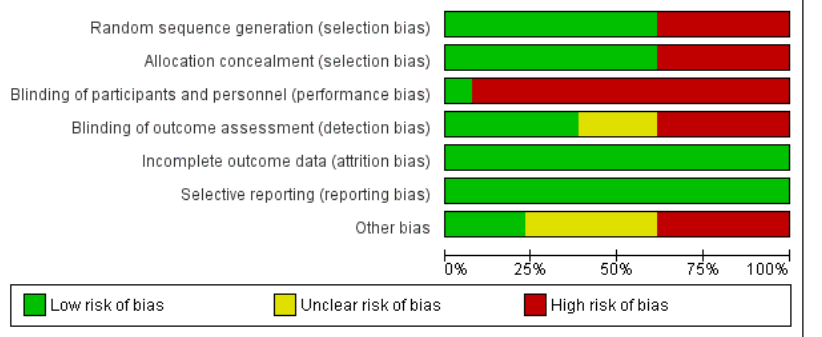
Figure 2. Risk of bias: reviewers ’ judgments of each element of risk of bias are presented as percentages across all included studies.